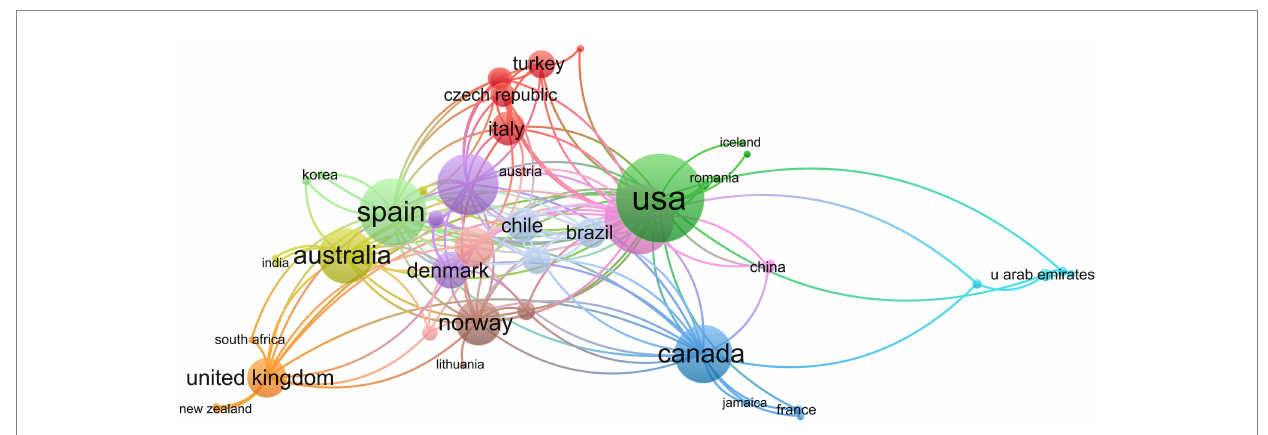
FIGURE 5 Map of inter-nation research